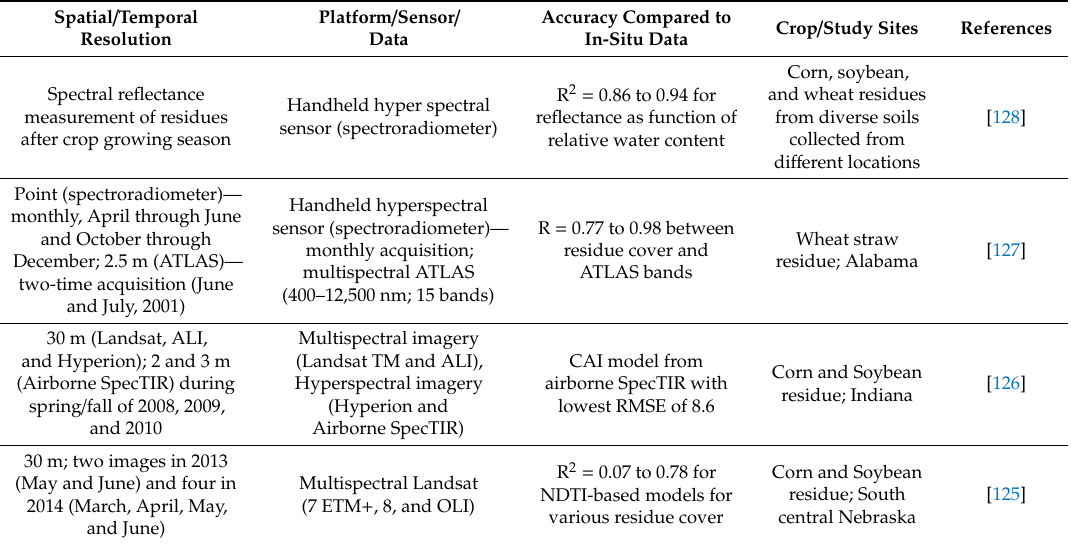
Table 11. Studies conducted for crop residue assessment using RS